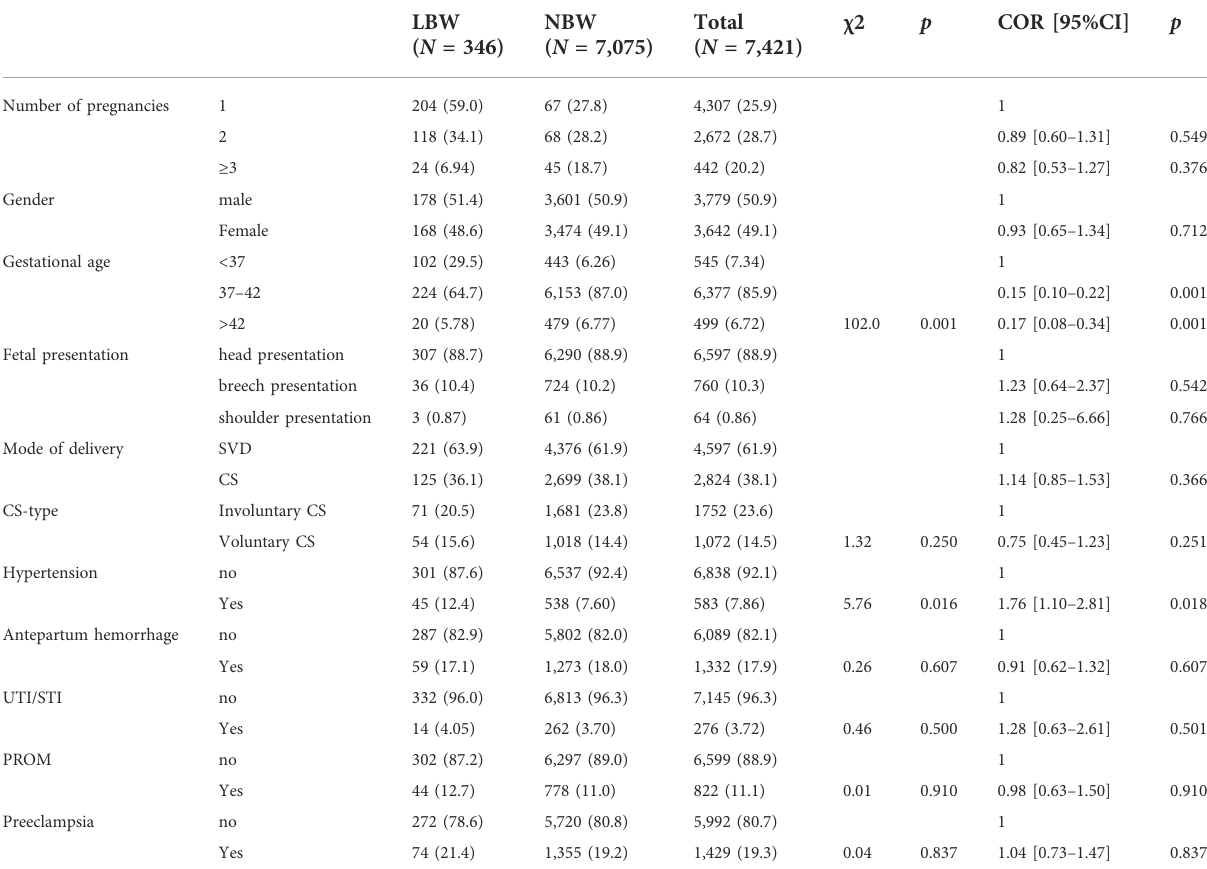
TABLE 2 Antenatal and obstetric factors associated with low birth weight.